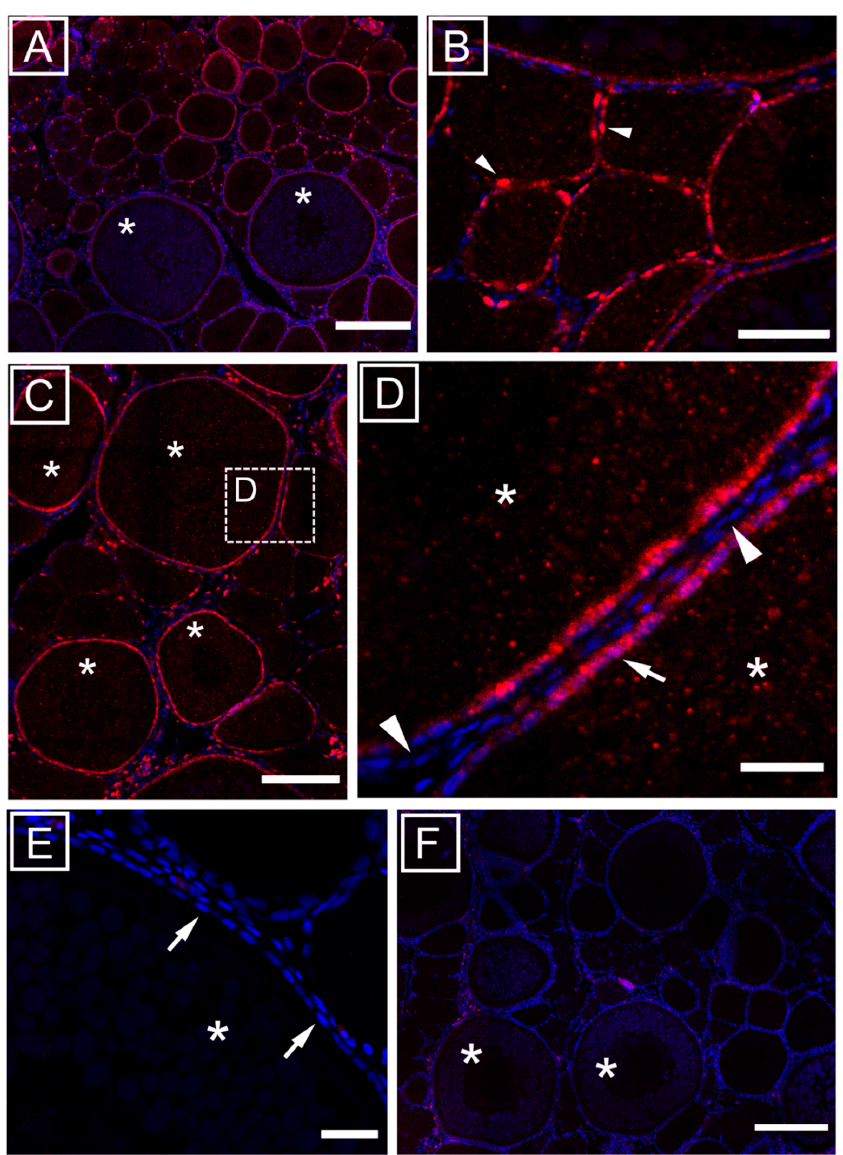
Figure 1. Localization of mir-202-5p expression (red signal) in the ovary revealed with fluorescent in situ hybridization (FISH). Nuclei are stained with DAPI (blue signal). ( A ) View of the ovarian section used for the experiment containing both vitellogenic and previtellogenic oocytes. The mir-202-5p was detected in granulosa cells of previtellogenic (( B ), arrowhead) and vitellogenic oocytes ( C ) but not in theca cells ( D ). The signal was also faintly detected in the ooplasm ( B , D ). Scramble control probe revealed no significant signal above background ( E , F ). Asterisks = vitellogenic oocytes, arrows = granulosa cells, arrowheads = theca cells. Scale bars ( A ) 200 μ m ( B ) 50 μ m ( C ) 100 μ m ( D ) 20 μ m ( E ) 20 μ m ( F ) 200 μ m.